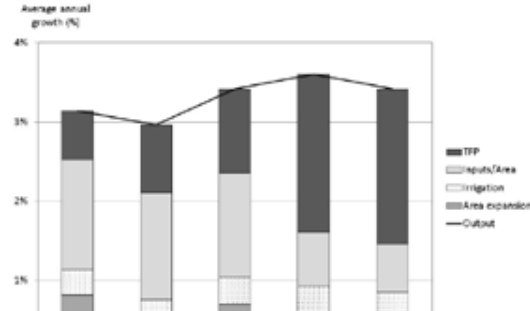
Panel A: Industrialized Countries.